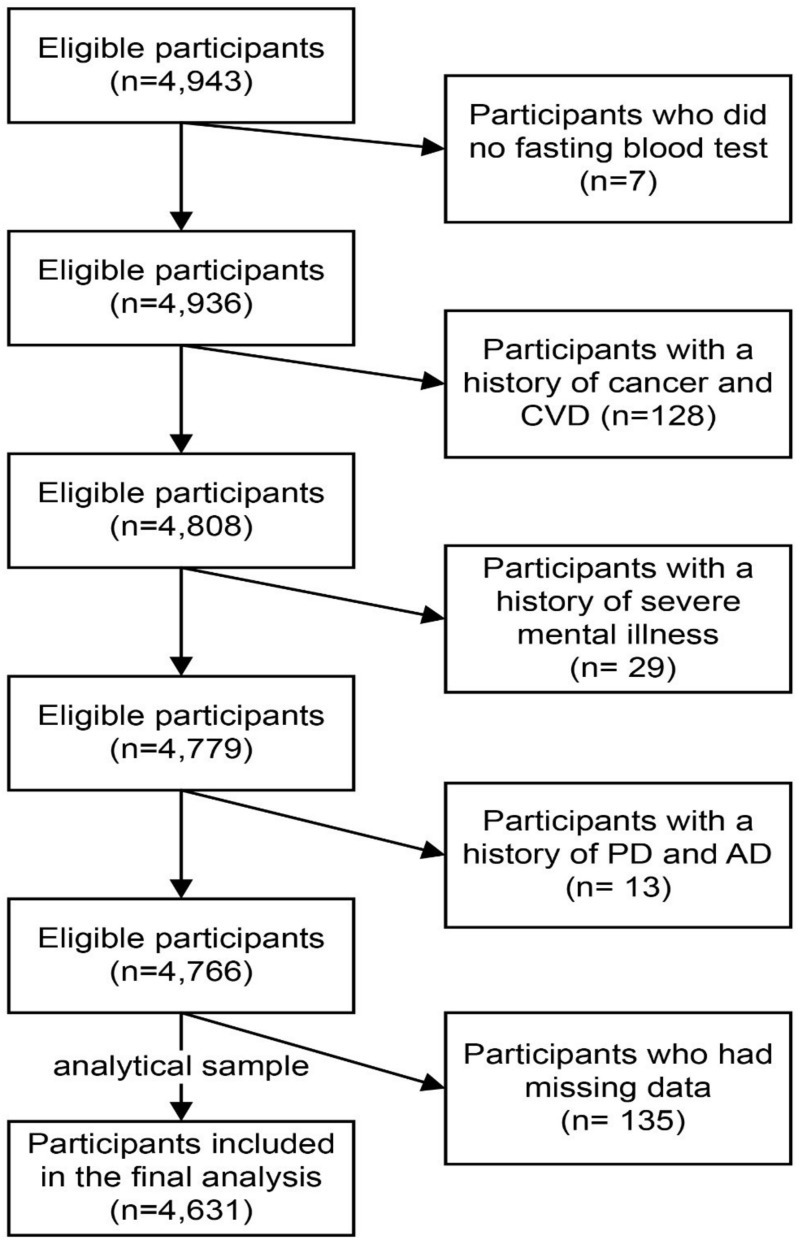
Flow diagram showing the selection of the study population. CVD, cerebrovascular disease; PD, Parkinson’s disease; AD, Alzheimer’s disease.